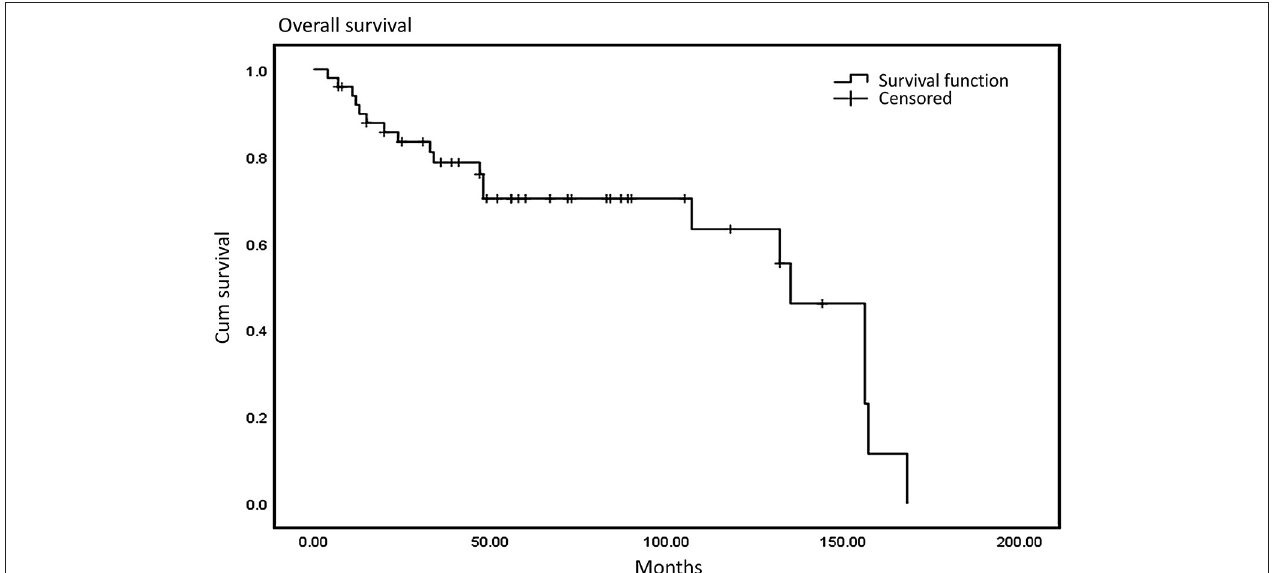
FIGURE 1 | Overall survival: the median OS was 48.5 months and the 3- and 5-year OS were 62 and 38%.